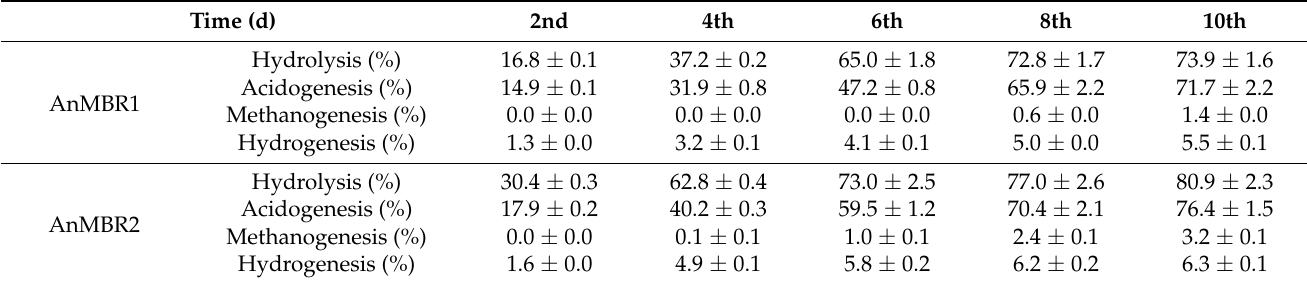
Figure 4. ( a ) Hydrolysis, ( b ) acidogenesis, ( c ) acetogenesis, ( d ) methanogens and ( e ) hydrogenase activities of AnMBR1 and AnMBR2. Table 4. Kinetic conversion efficiencies of AnMBR1 and AnMBR2 at OLR 2 g-VS/(L·d) (%).